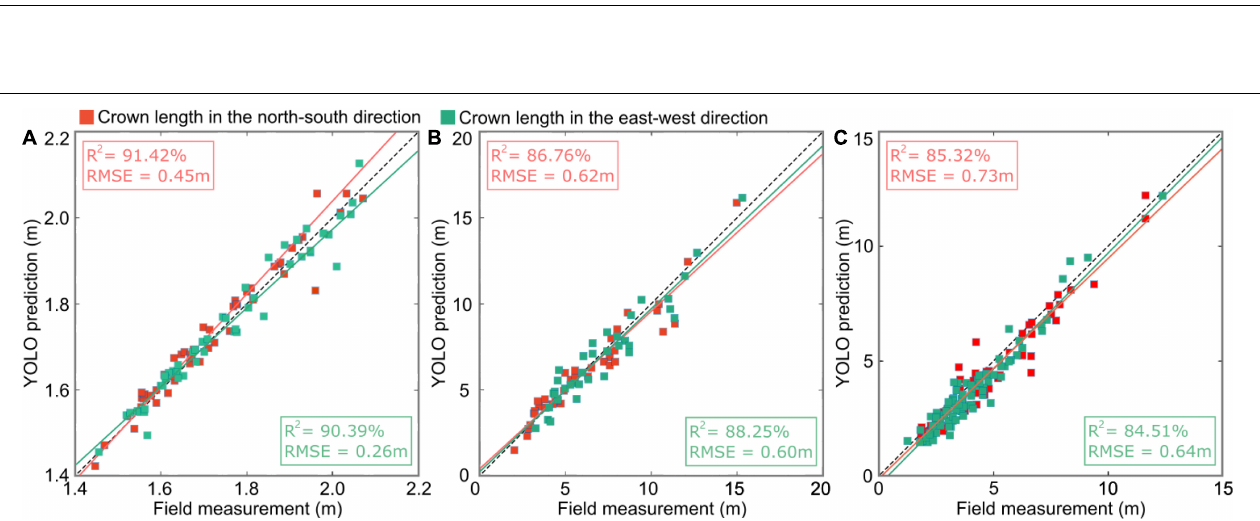
FIGURE 16 | Scatter plots showing the relationship of the predicted crown lengths from improved YOLO-v4 versus the field measurement data in (A) sample plot 1 of the tree nursery, (B) plot 5 of the forest landscape, and (C) plot 7 of the mixed tree plantation, where the red squares represent the crown lengths in the N–S direction and the green squares represent the crown lengths in the E–W direction. The red and green lines are the fitted lines for the N–S direction and E–W direction using least squares regression, respectively.